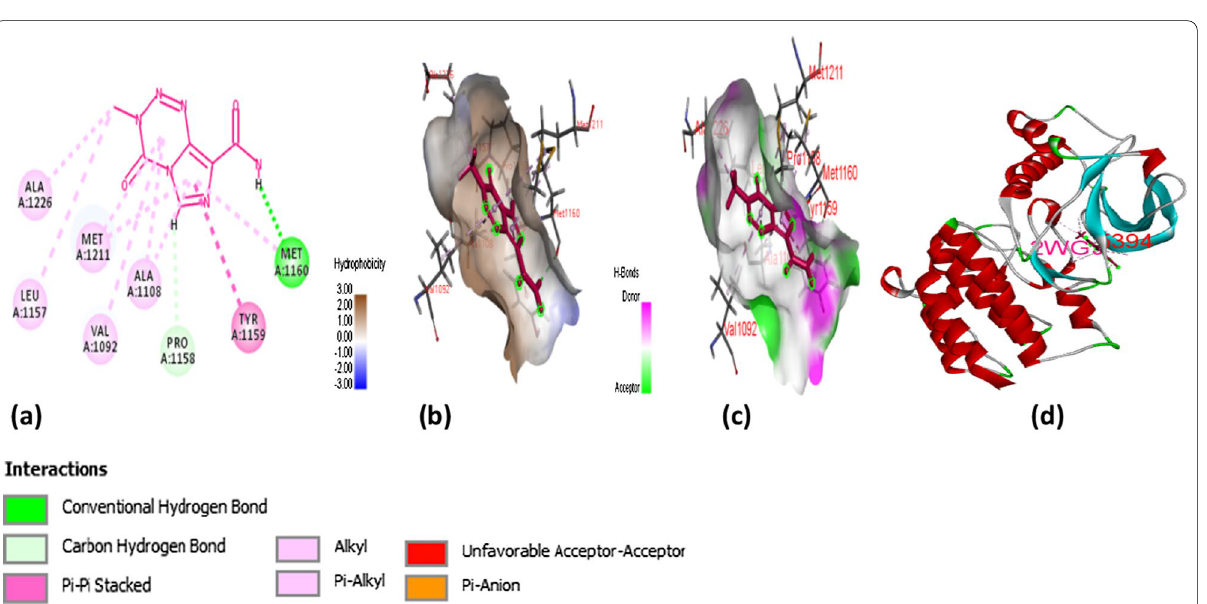
Fig. 9 2D and 3D interaction images of drug Temozolomide at the binding sites of protein C-MET (2WGJ: DIRECT